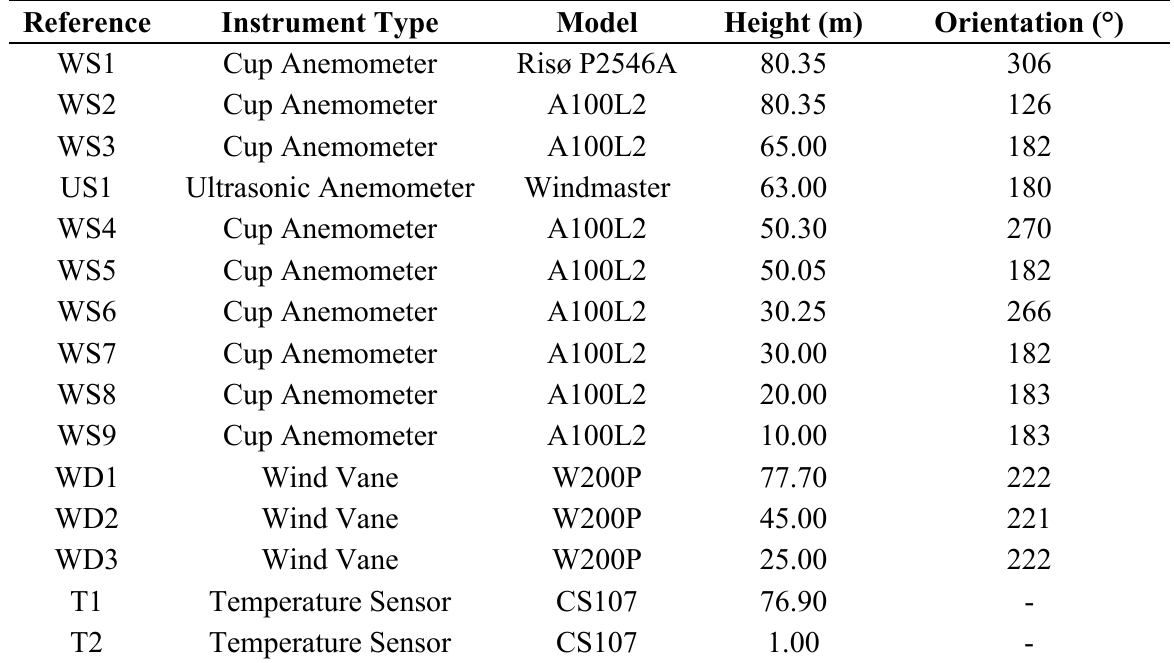
Table 1. Monitoring mast